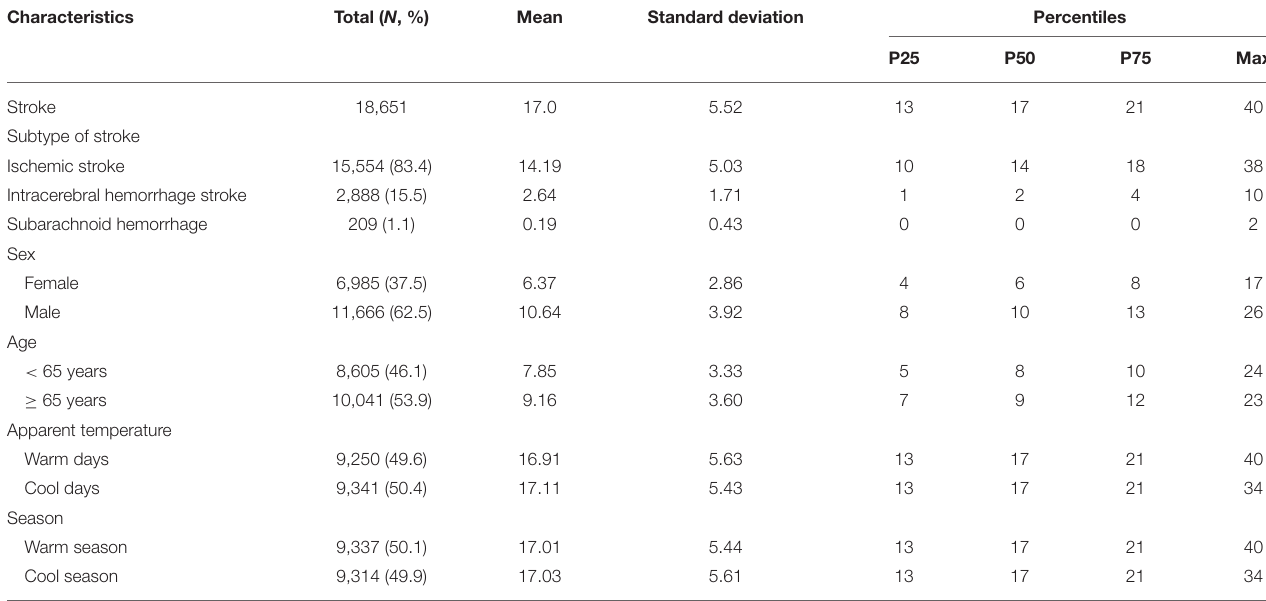
TABLE 1 | Summary statistics of daily hospital admissions for stroke in four hospitals in Shanghai, 2014–2016. Characteristics